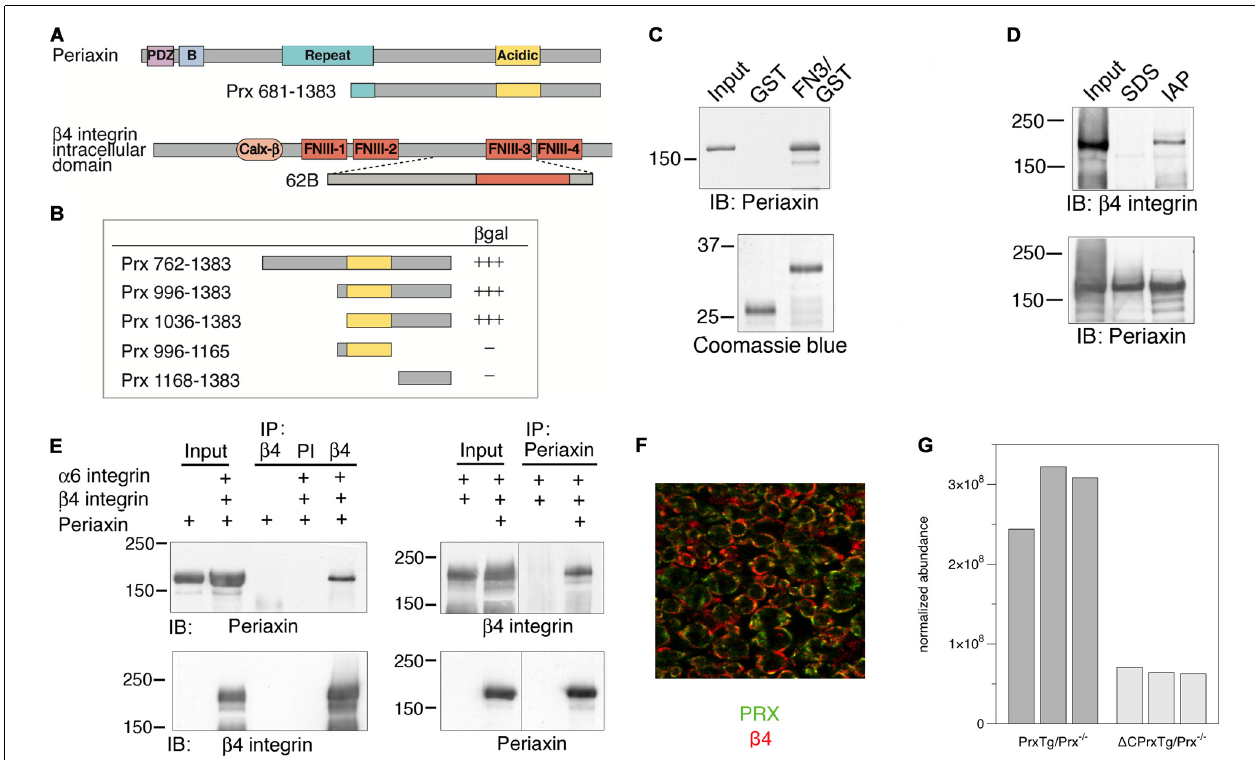
FIGURE 1 | Identification of an interaction between periaxin and β 4 integrin. (A) Top: structure of full-length L-PRX and the bait used in a yeast two-hybrid screen using the C terminus of L-PRX (aa 681–1383) fused to the GAL4 DNA-binding domain. Bottom: structure of the intracellular domain of β 4 integrin and one (62B) of the three clones recovered from the screen, all of which included the third FNIII domain of β 4 integrin. (B) Identification of the region of PRX, which binds to β 4 integrin. The strength of interaction between the 62B clone and a series of PRX constructs in a yeast two-hybrid β -galactosidase assay was assessed semiquantitatively by the time taken for colonies to turn blue (+++, 30 min; ++, 30–60 min; +, 60–180 min). (C) Interaction of β 4-FNIII-3 with PRX in vitro . GST or a GST- β 4-FNIII-3 fusion protein were incubated with a sciatic nerve lysate in vitro and any bound L-PRX was detected by Western blotting (IB) using a PRX antibody after SDS-PAGE. The input lane confirms the presence of PRX in the lysate. Coomassie blue staining shows that equivalent amounts of GST and the GST fusion proteins were used. (D) Immunoaffinity copurification of β 4 integrin and PRX. Detergent extracts of mouse sciatic nerve in the non-ionic detergent Igepal were incubated with beads, to which affinity-purified sheep anti-PRX antibodies had been covalently coupled. After extensive washing, bound proteins were eluted and analyzed by SDS-PAGE and Western blotting. The SDS control lane contains proteins that bound to the beads after first solubilizing the nerves in SDS to disrupt protein-protein interactions, followed by dilution of the SDS with Triton X-100. (E) Coimmunoprecipitation of β 4 integrin and PRX from transfected HEK293 cells. PRX and β 4 integrin were detected by Western blot (IB) after immunoprecipitation (IP) with β 4 integrin antibodies when β 4 integrin, α 6 integrin, and PRX were coexpressed. Preimmune serum (PI) did not precipitate either protein. Reciprocally, β 4 integrin and PRX were detected by Western blot after IP with anti-PRX antibodies, when β 4 integrin, α 6 integrin, and PRX were coexpressed. (F) Immunohistochemistry. Both PRX (green) and β 4 integrin (red) localize at the abaxonal membrane in mature myelin. (G) Quantification of β 4 integrin from the IP of crosslinked sciatic nerves from the full-length PRX transgenic mouse on a PRX null background ( n = 3) vs. C-terminally truncated PRX transgene on a PRX null background ( n =